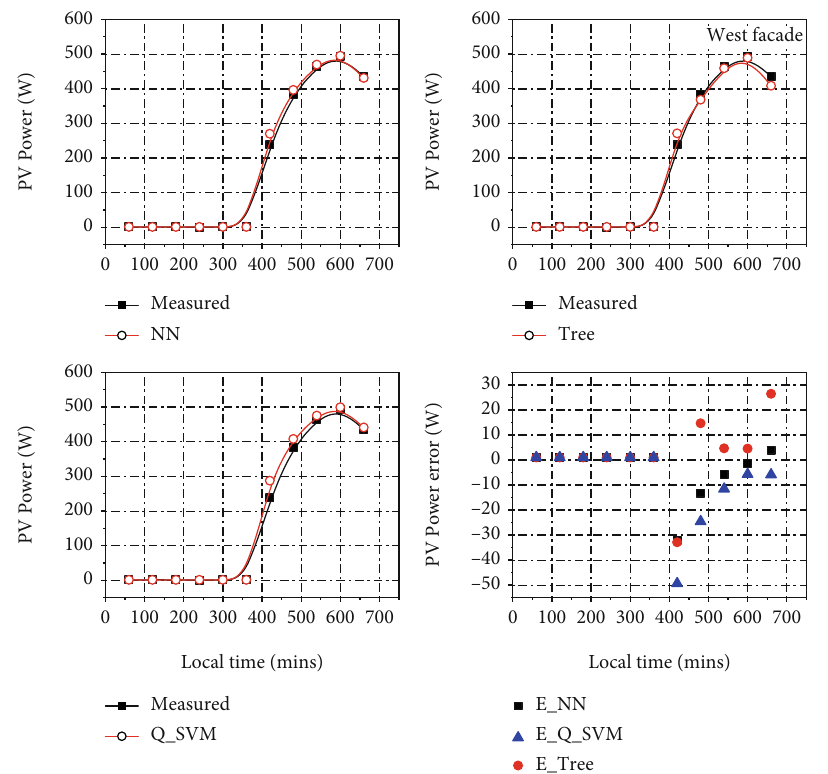
Figure 10: PV power prediction and error of the NN-QSVM-Tree models for the west façade. Table 2: Performance of the machine learning algorithms. Algorithm Application